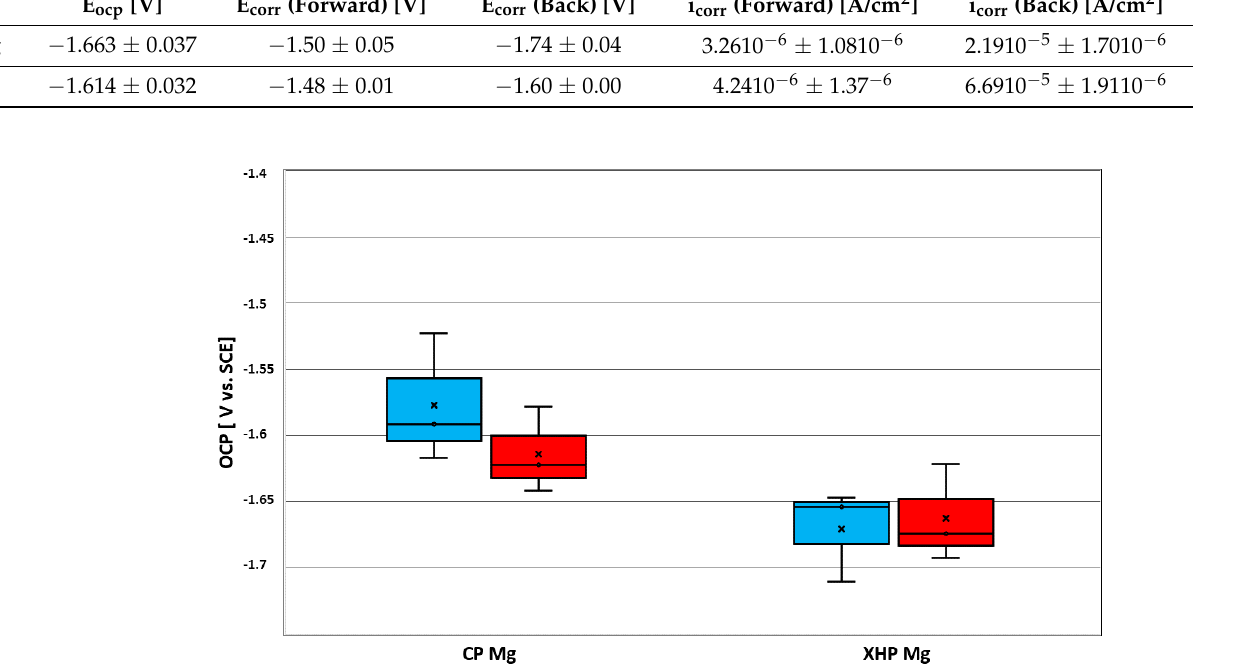
Figure 6. E OCP after 30 min of XHP and cp magnesium in MEM at stationary and dynamic electrolyte flow conditions, at 25 °C. Left box relates to stationary and the right box to dynamic conditions.